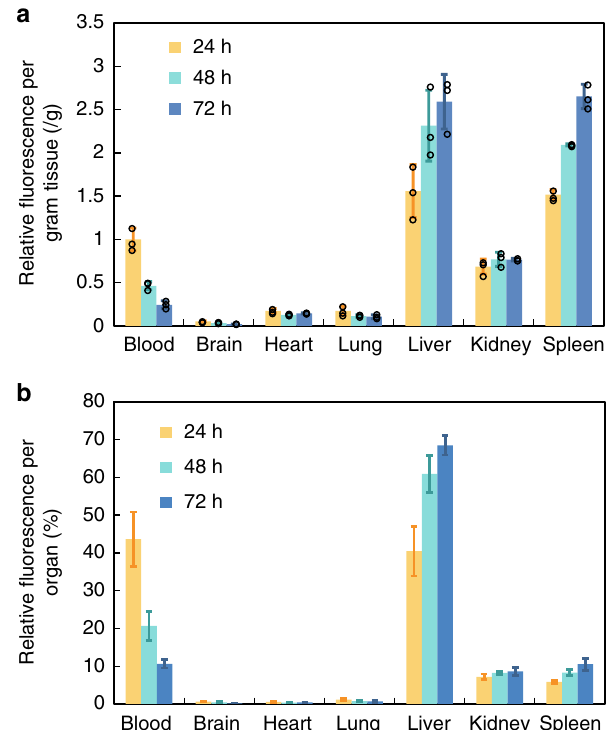
Fig. 6 Biodistribution in mice of BCCs after 7 days of crystallization. At different time points (24, 48, and 72 h), fl uorescence intensity of homogenized tissues were measured. a Fluorescence intensity per gram of tissue. Individual data points are shown in circles. b Relative fl uorescence signal per organ. Error bars, mean ± s.d, n =